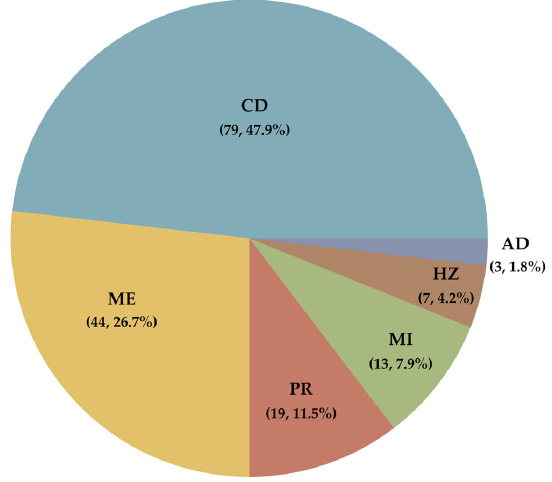
Figure 4. Frequency distribution of the Asian dust (AD), haze (HZ), mist (MI), precipitation (PR), multiple events (ME), and clear days (CD) cases for the spring, 2009–2011 in Busan. Values in parenthesis indicate frequency number and percentage (%), respectively.